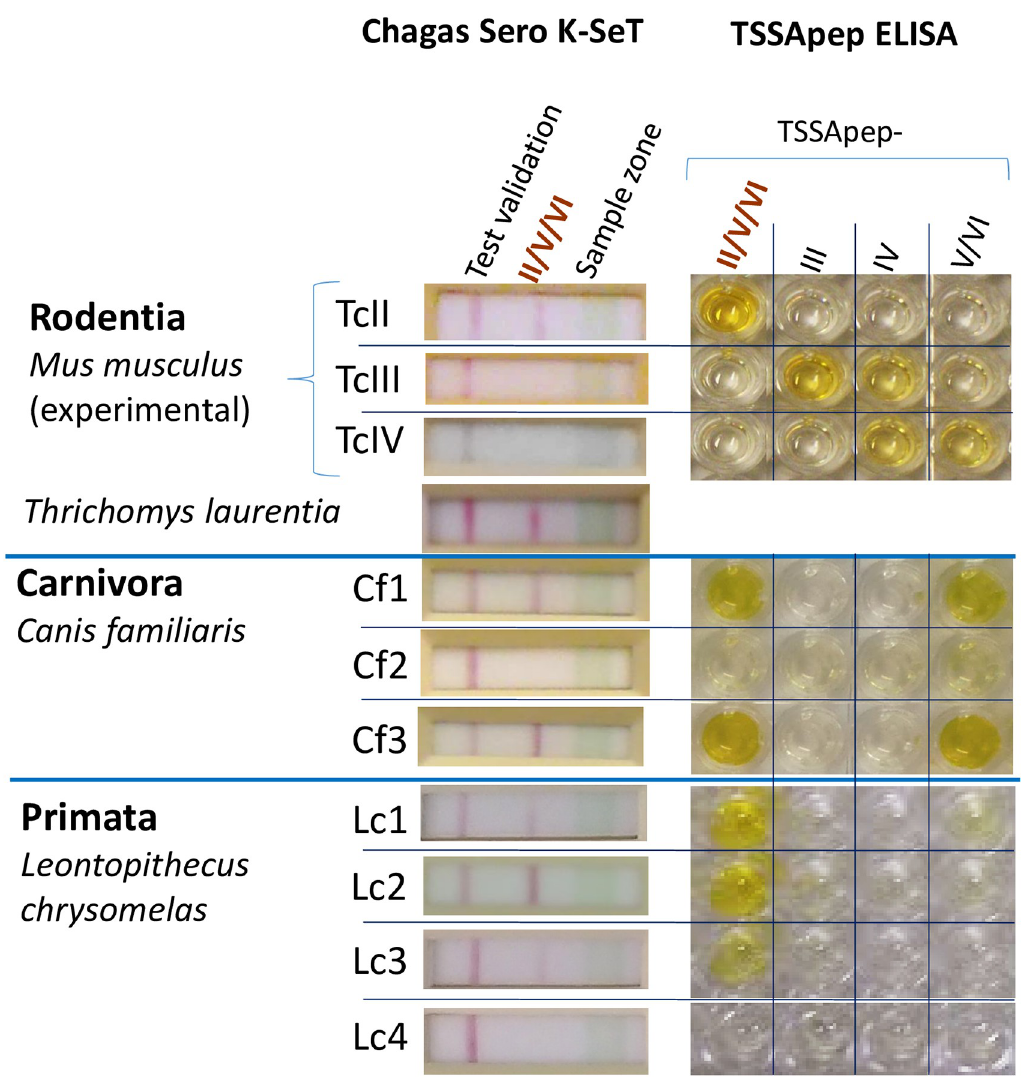
Fig 2. Concordance of TSSApep ELISA and Chagas Sero K -Set across mammalian Orders. Representative samples from experimental T . cruzi murine infections and natural infections of Thrichomys laurentius (Rodentia: Echimyidae), Canis familiaris (Carnivora: Canidae) and Leontopithecus chrysomelas (Primata: Callitrichidae). For primate samples, Kappa test = 0.84, 95% confidence intervals (0.64–1.00). Sample Lc4 was T . cruzi seronegative. The T . laurentius sample shown here did not have a corresponding